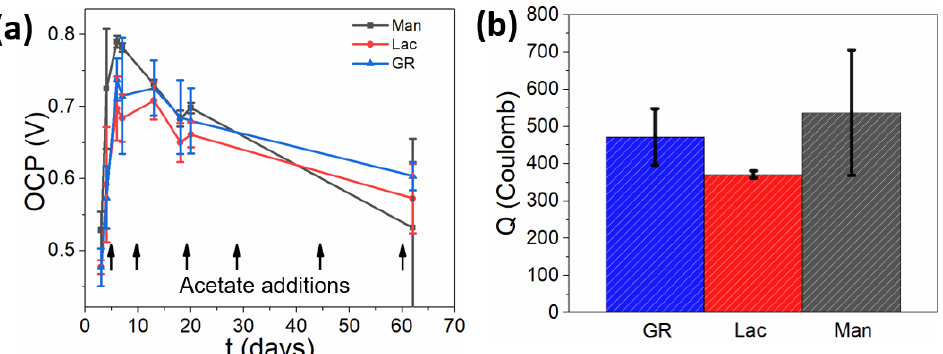
Figure 6. ( a ) Open-circuit potential (OCP) average of all MFC devices tested as a function of time. Black arrows indicate when fresh solution (PBS + sodium acetate) was added to the anode compartment as nutrient. ( b ) Total integrated charge obtained from the MFC devices over the duration of the experiment (1000 Ω load).